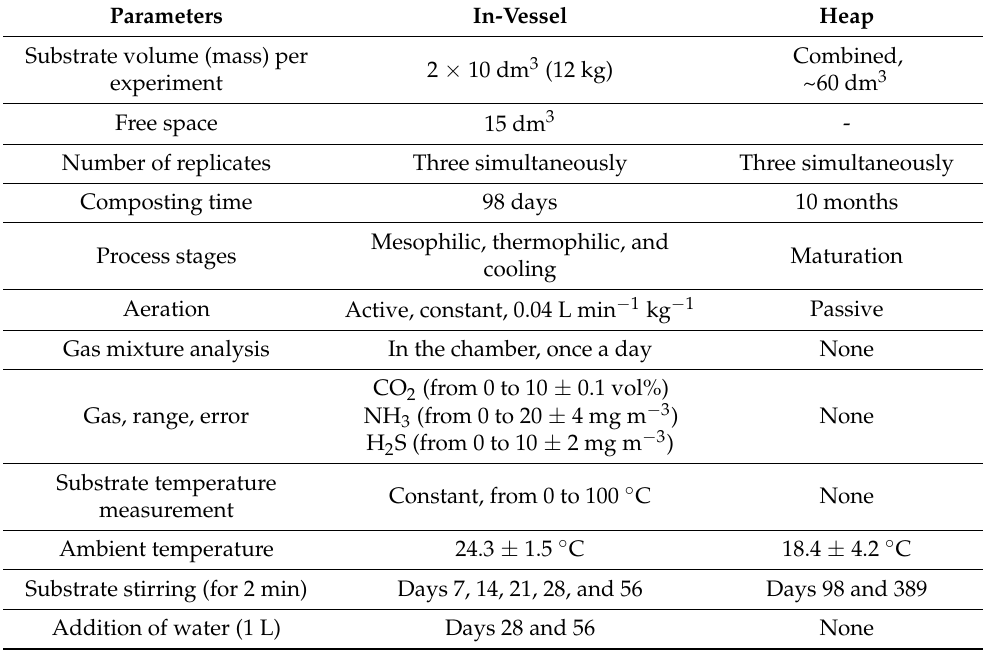
Table 2. The parameters for the composting process.